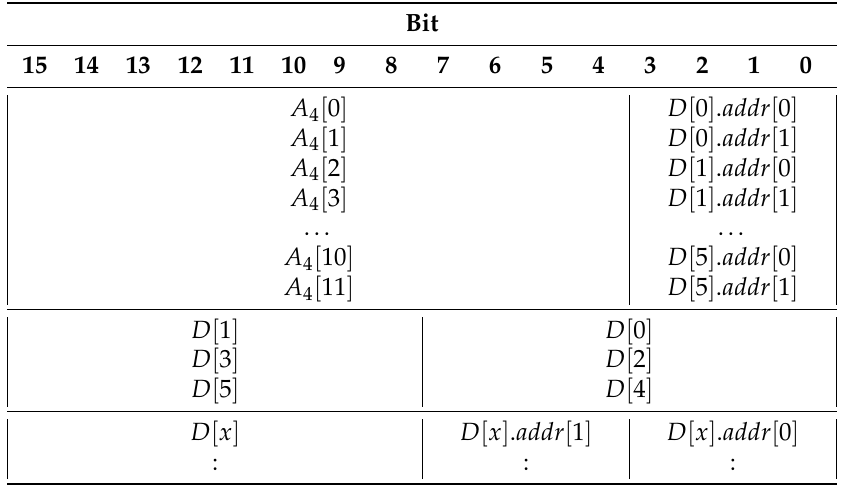
Table 1. The compressed EDA data structure— ˆ W 4 .